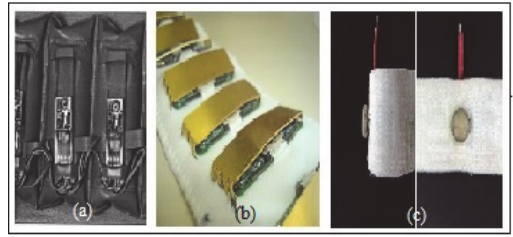
Fig. 5: (a) Inflatable belt [21] (b) Active electrode belt [22] (c) Nano fiber web electrode belt